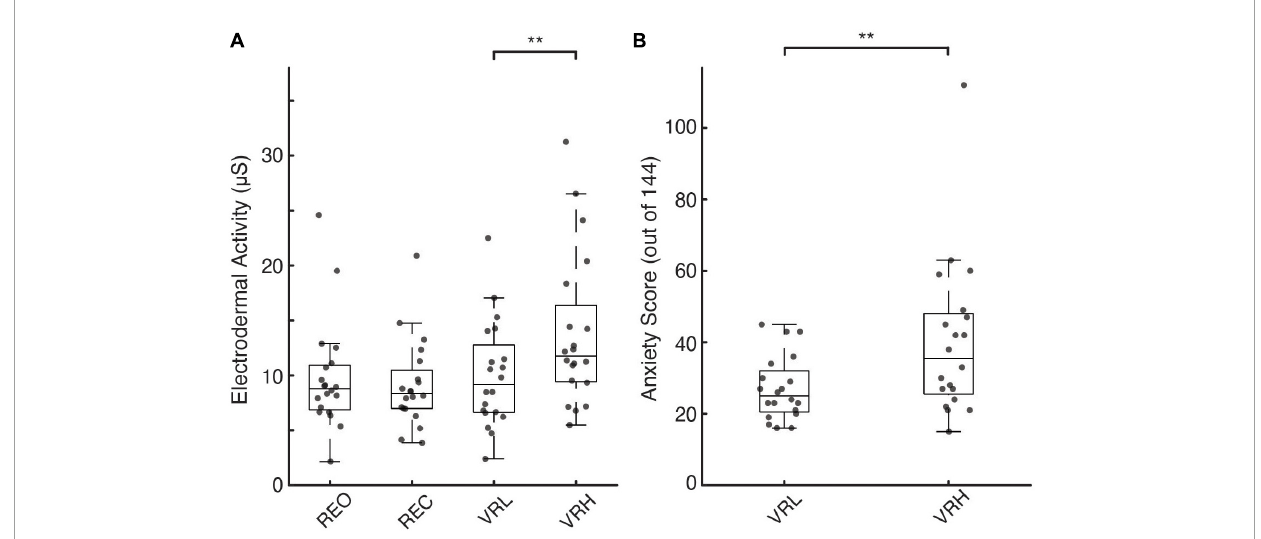
FIGURE2 Physiological and perceptual indicators of postural threat-induced fear and anxiety. (A,B) Individual participant (gray circles) and box plots showing median and interquartile range for EDA under real (A) and virtual environments. (B) Individual and average participant questionnaire anxiety rating scores (out of a total of 0-144 points) under the different VR conditions. Asterisks denote significance at the p < 0.01**